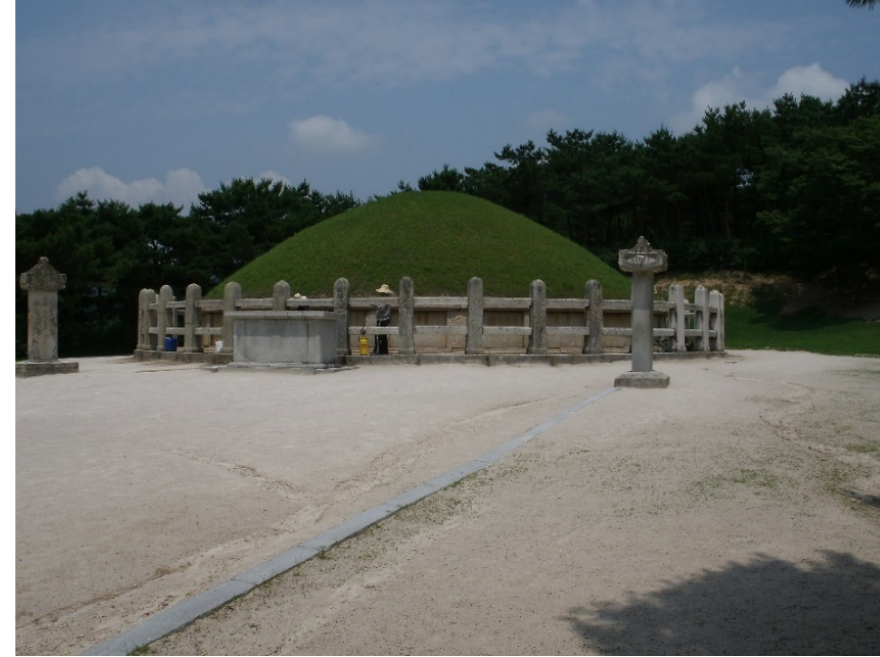
Figure 12. Tumulus of Hwangnam-ri. Gyeongju (Korea).